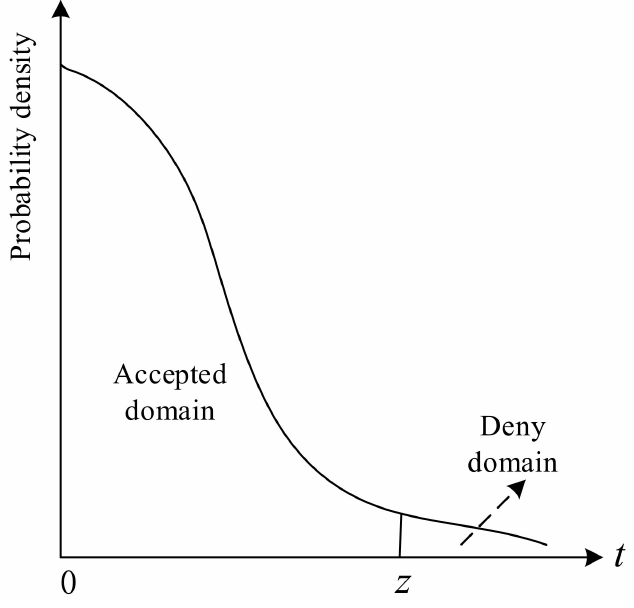
Figure 8. One-tailed t